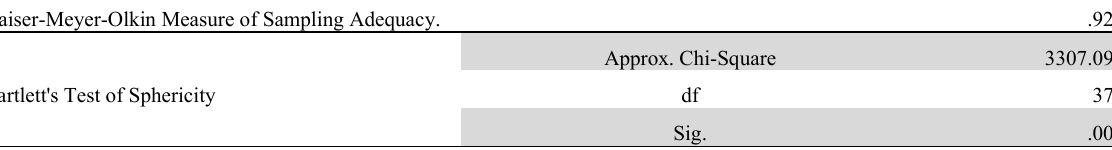
KMO and Bartlett's